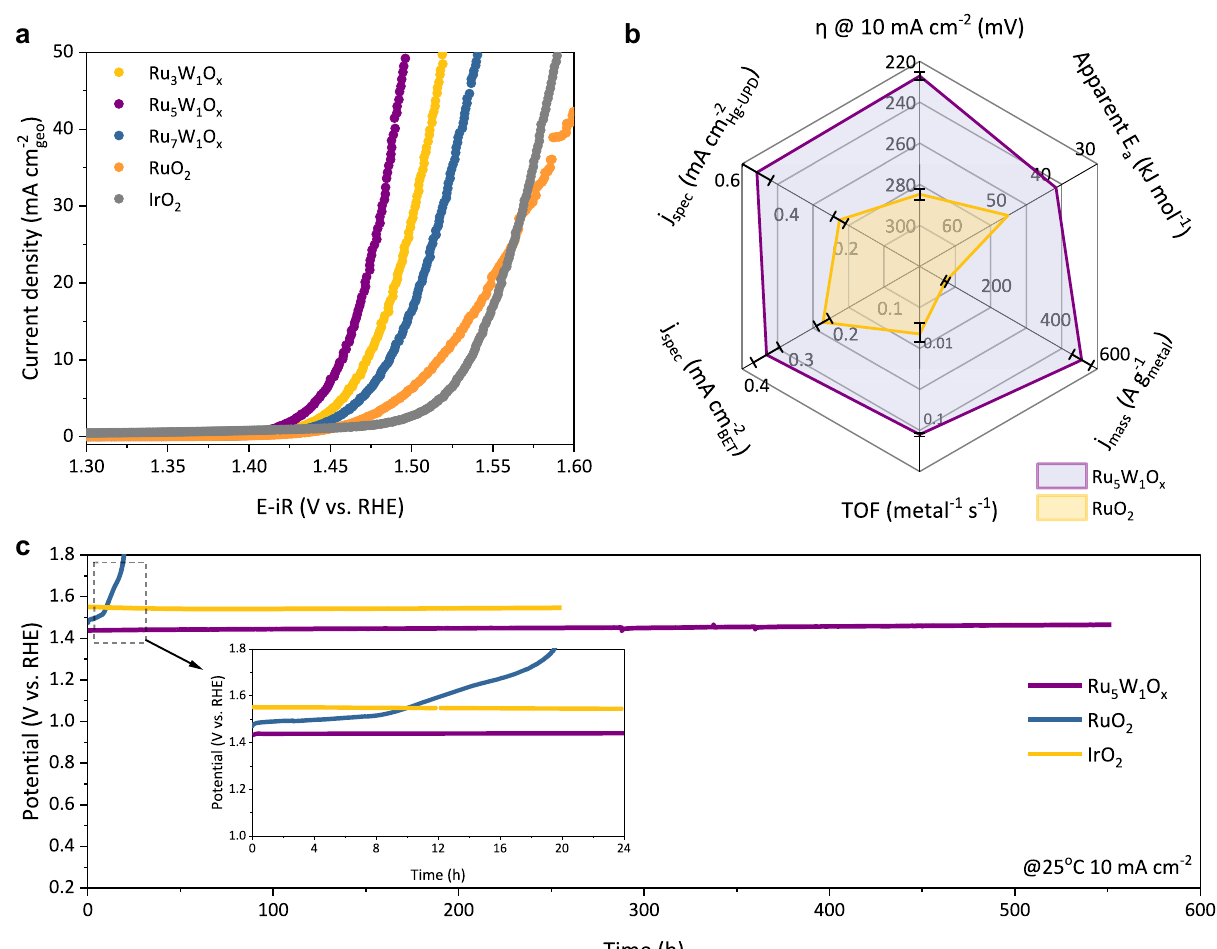
Fig. 2 | Electrochemical performance of Ru-W oxides. a The LSV curves of dif- ferent catalysts with 95%iRcompensation. Scan rate: 5mVs − 1 . b Summaryofsome major OER performance metrics of Ru 5 W 1 O x and RuO 2 . The speci fi c OER activity ( j spec ) (normalized by BET surface area and Hg-UPD surface area respectively) was calculated at 1.50V vs . RHE. The apparent activation energy ( E a ) was calculated by